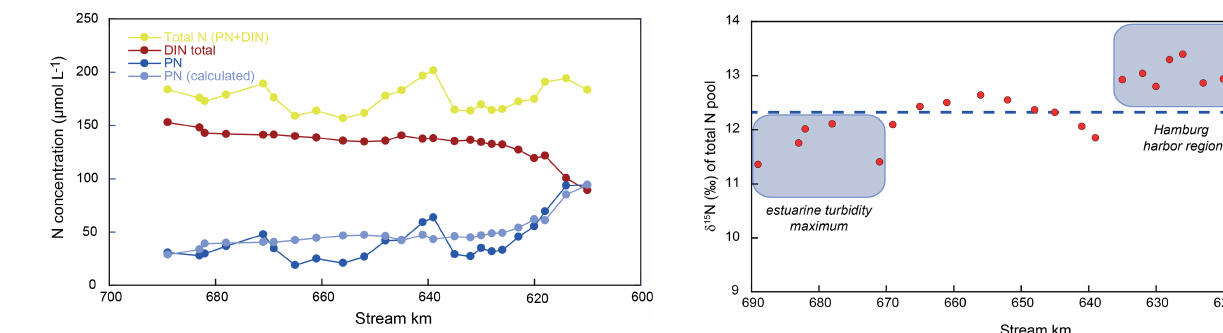
Figure 6. Total N isotope values along our sampling stretch. The dashed blue line represents the isotope mass-balance-conserved input from the uppermost reach. Red dots represent the mass- weighted total N pool, and deviations from the expected line indi- cate the addition or removal of N beyond isotope-neutral processes. The harbor region appears to host the removal of low δ 15 N, leading to this deviation from the expected isotope mass balance. As noted in the text, this is consistent with water column denitrification oc- curring in the low-O 2 waters of the harbor. In the estuarine turbidity maximum, either high- δ 15 N nitrogen is removed or low- δ 15 N nitro- gen is added. The reader is referred to Sect. 4.4 for